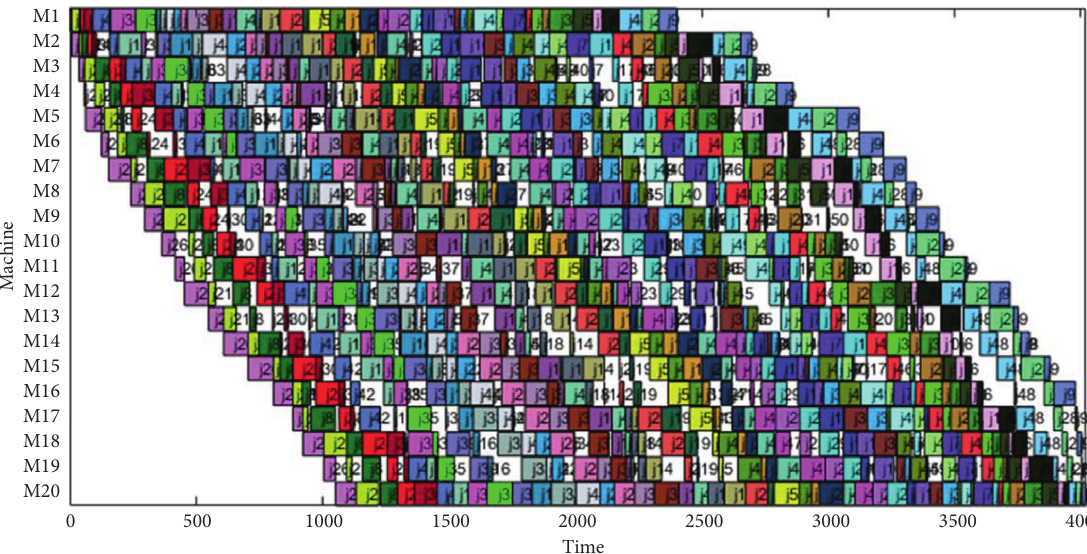
Figure 8: Gantt chart of the solution with GA (workpiece: 50, machine: 20, makespan: 4017.85).